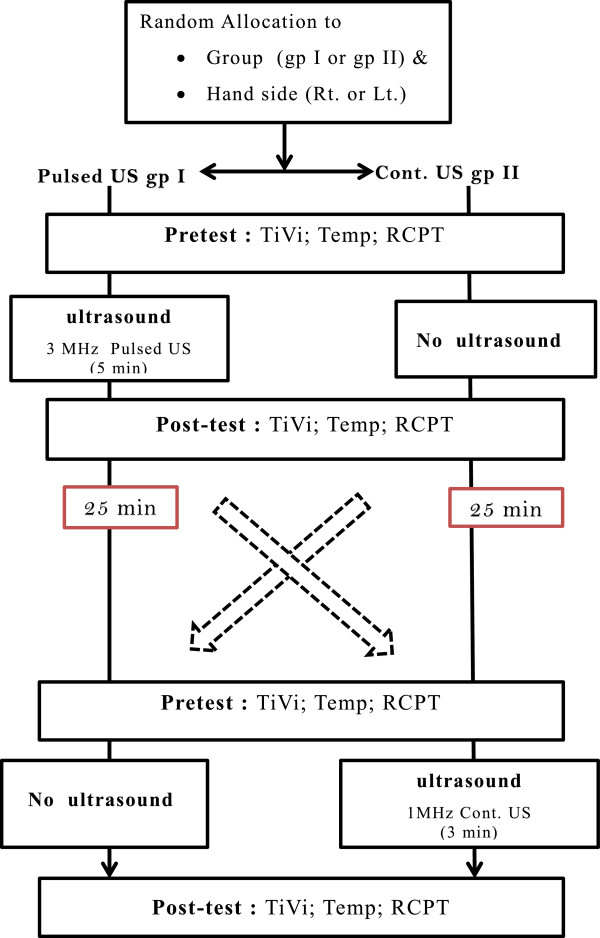
Flow chart for the study design (cross-over AB/BA).